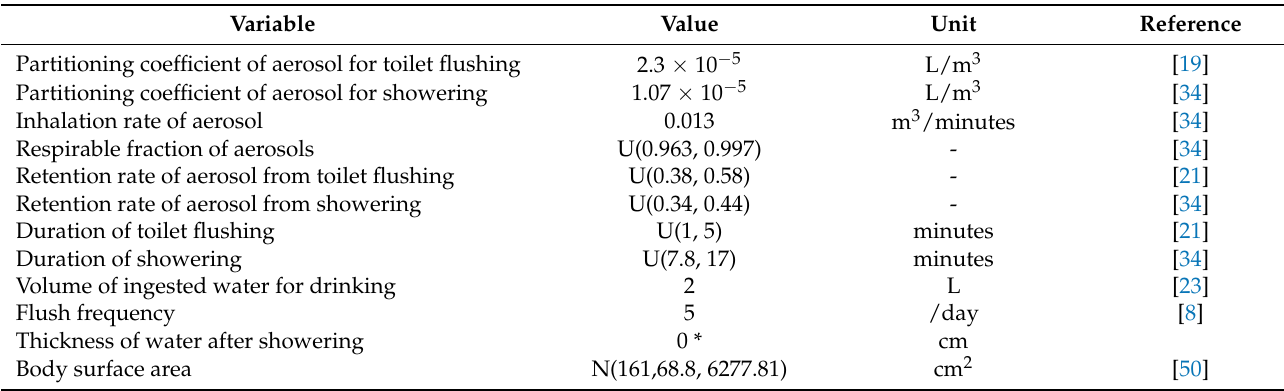
Table 2. Exposure parameter values.